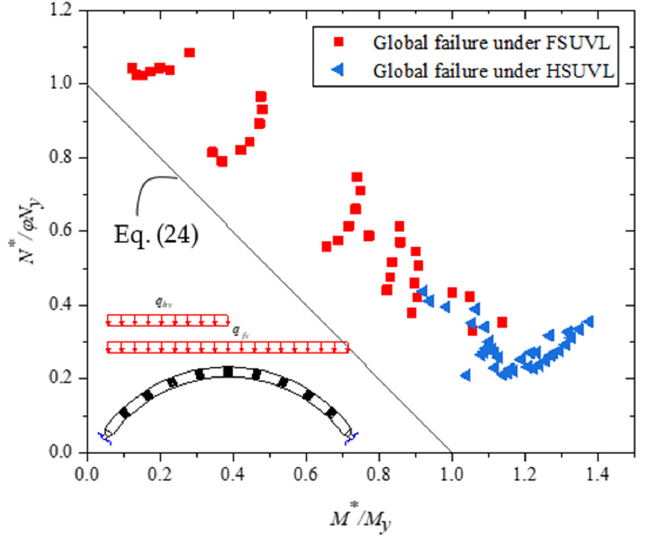
Figure 17. Comparison of Equation (24) and FE results under F(H)SUVL.